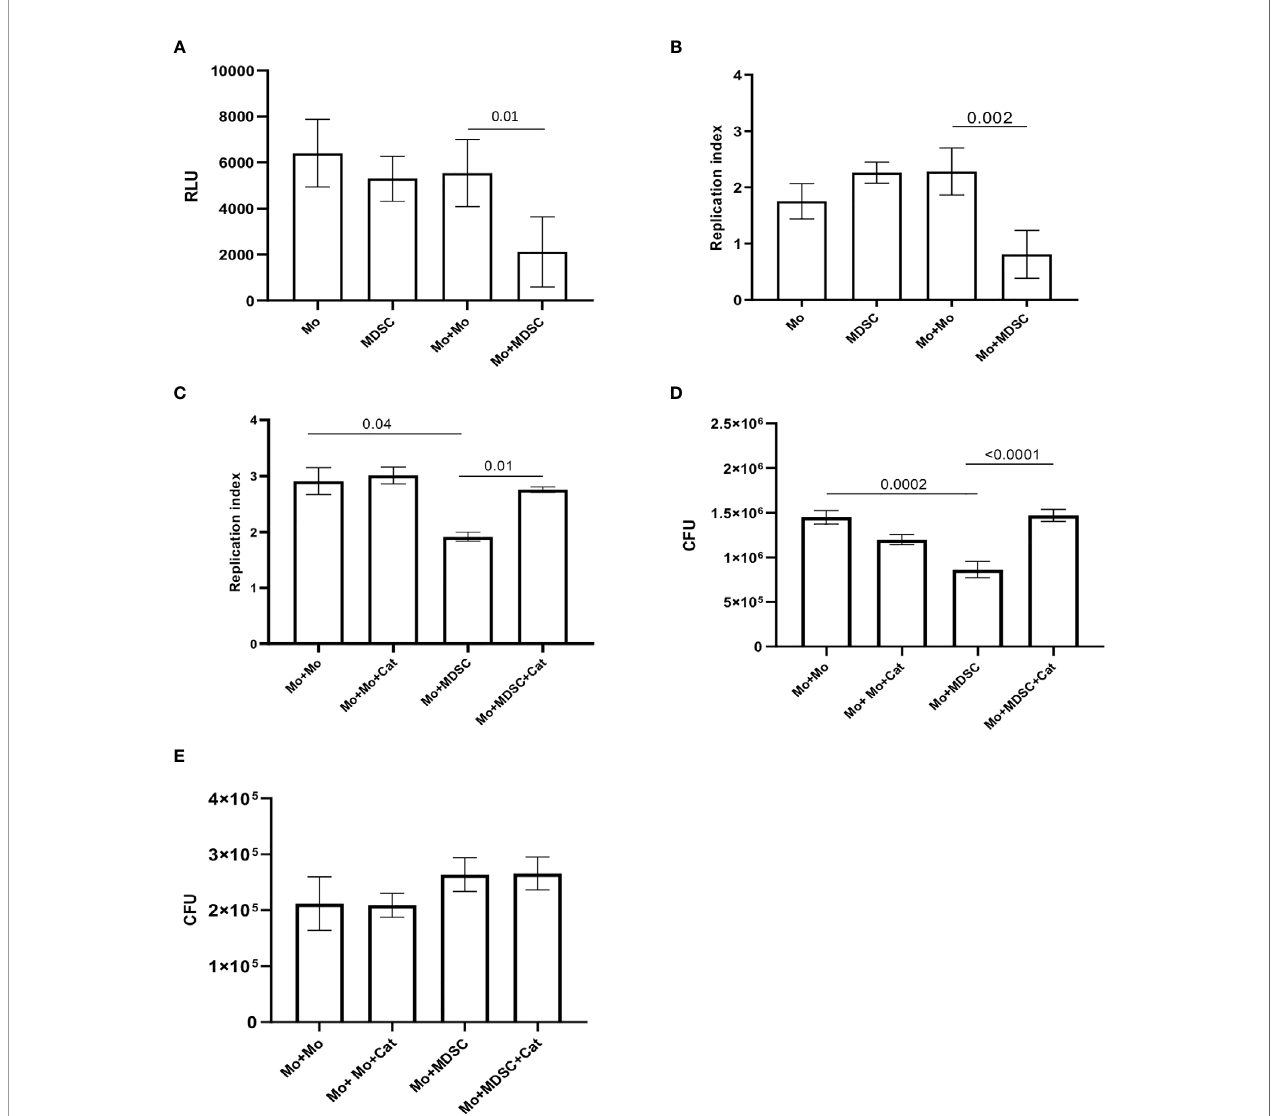
FIGURE 5 | PMN-MDSC induce BCG and not MTB growth inhibition into monocytes. Relative Luminescence Unit (A) and Replication index (B) of BCGlux 3 days post infection into puri fi ed monocytes alone (Mo) or cultured with not infected puri fi ed PMN-MDSC (ratio 1/1, Mo+MDSC), or with not infected monocytes as control (ratio 1/1, Mo+Mo). PMN-MDSC infected with BCGlux alone was also evaluate (MDSC). Results are shown as mean ± SE of four independent experiments. (C) Replication index of BCGlux after 3 days of infection of puri fi ed monocytes (Mo) cultured with not infected puri fi ed PMN-MDSC (ratio 1/1, Mo+MDSC), or with not infected monocytes as control (ratio 1/1, Mo+Mo) in the presence or absence of polyethylene glycol-Catalase (Cat). Results are show as mean ± SE of replicates of one experiment (cells from one donor). (D) Colony Forming Unit (CFU) of wild type BCG after 3 days of infection of puri fi ed monocytes (Mo) cultured with not infected puri fi ed PMN-MDSC (ratio 1/1, Mo+MDSC), or with not infected monocytes as control (ratio 1/1, Mo+Mo) in the presence or absence of polyethylene glycol-Catalase (Cat). Results are show as mean ± SE of replicates of one out of two independent experiments (cells from two donors). A paired T test was used, and p <0.05 was considered statistically signi fi cant. Mo, monocytes; PMN-MDSC, polymorphonuclear-myeloid-derived suppressor cells. (E) Colony Forming Unit (CFU) of MTB (H37Rv) after 3 days of infection of puri fi ed monocytes (Mo) cultured with not infected puri fi ed PMN-MDSC (ratio 1/1, Mo+MDSC), or with not infected monocytes as control (ratio 1/1, Mo+Mo) in the presence or absence of polyethylene glycol-Catalase (Cat). Results are show as mean ± SE of three independent TGF-beta is highly expressed by MDSC, and could involve in the ROS-mediate BCG replication control by monocytes. Differently from BCG, PMN-MDSC did not induce MTB growth inhibition by monocytes. This difference may be due to the ability of MTB killing, in particular, to inhibit ROS production (47).